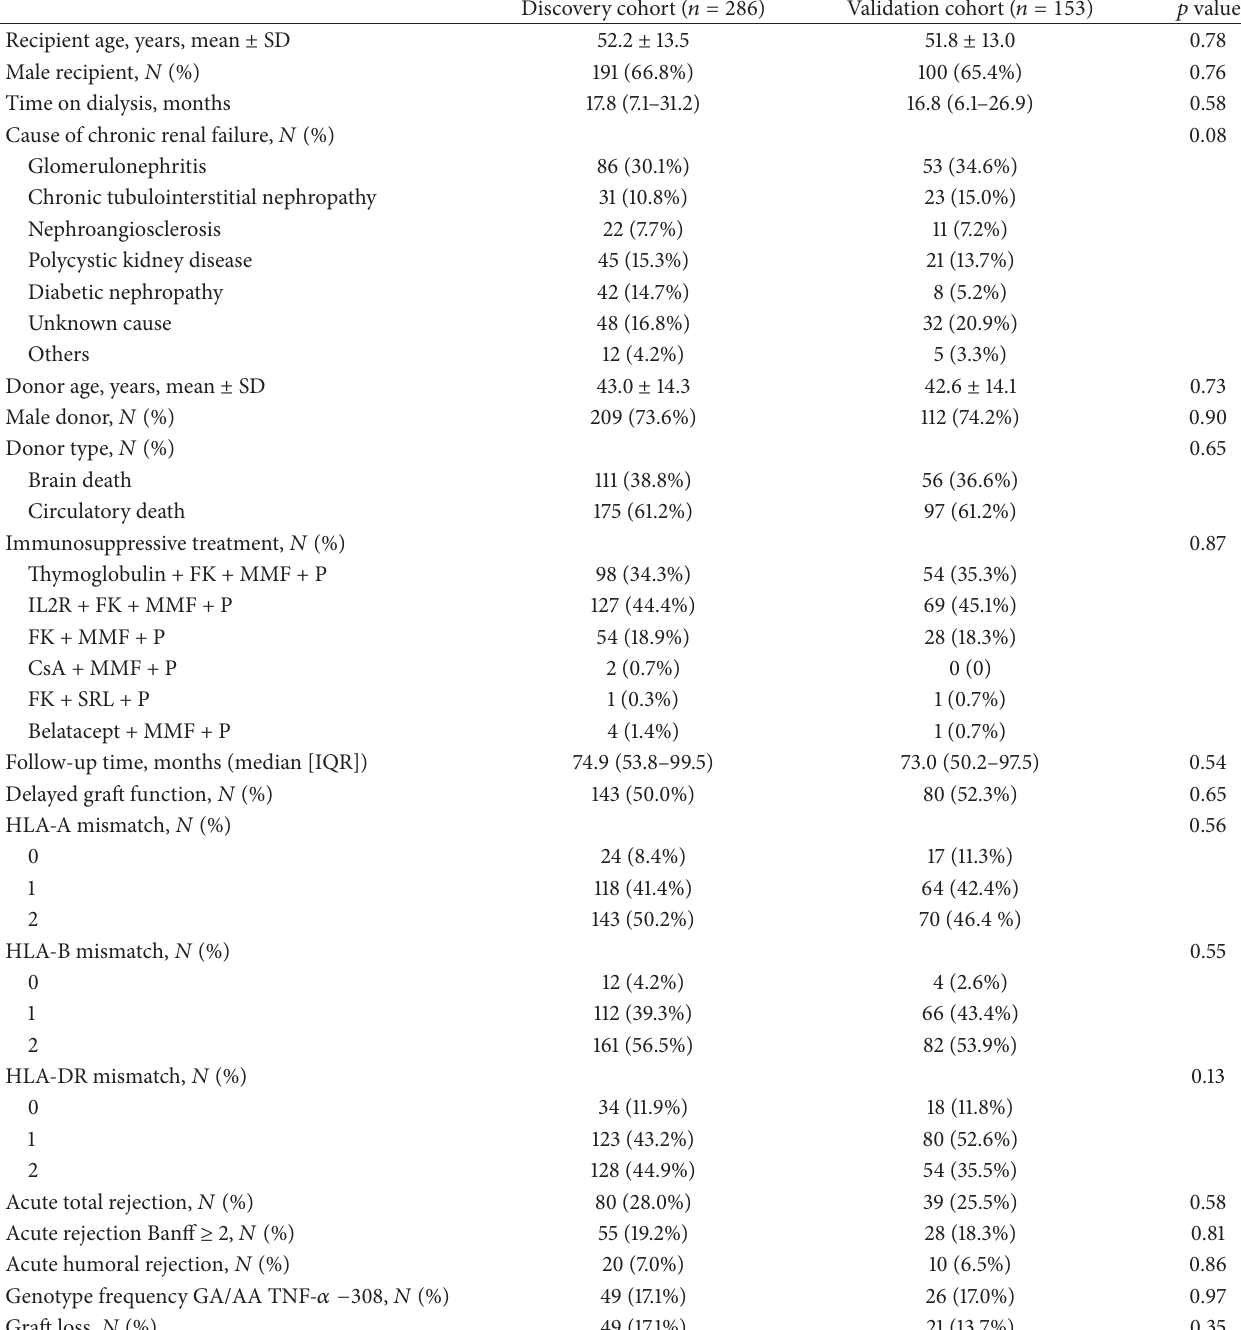
Table 1: Characteristics of the two randomly divided cohorts of kidney